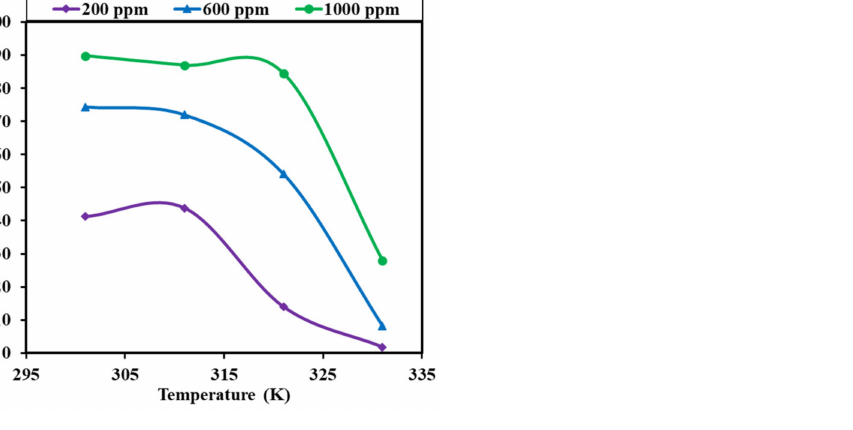
Figure 8. Variations in the inhibition efficiency with temperature on mild steel in the presence of 200, 600, and 1000 ppm inhibitor in the 1 M H 2 SO 4